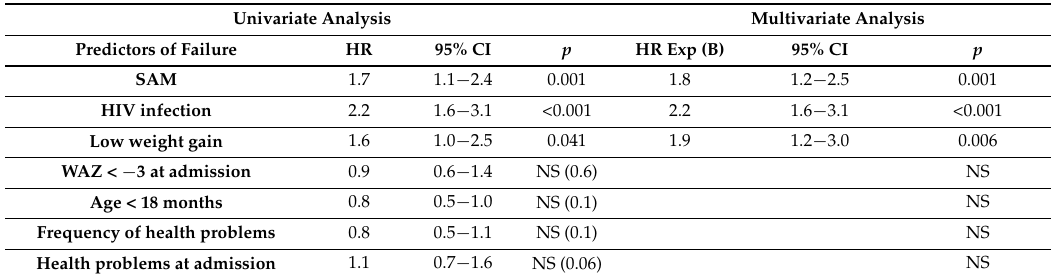
Table 5. Predictors of failed cured status. Cox proportional risk analysis.